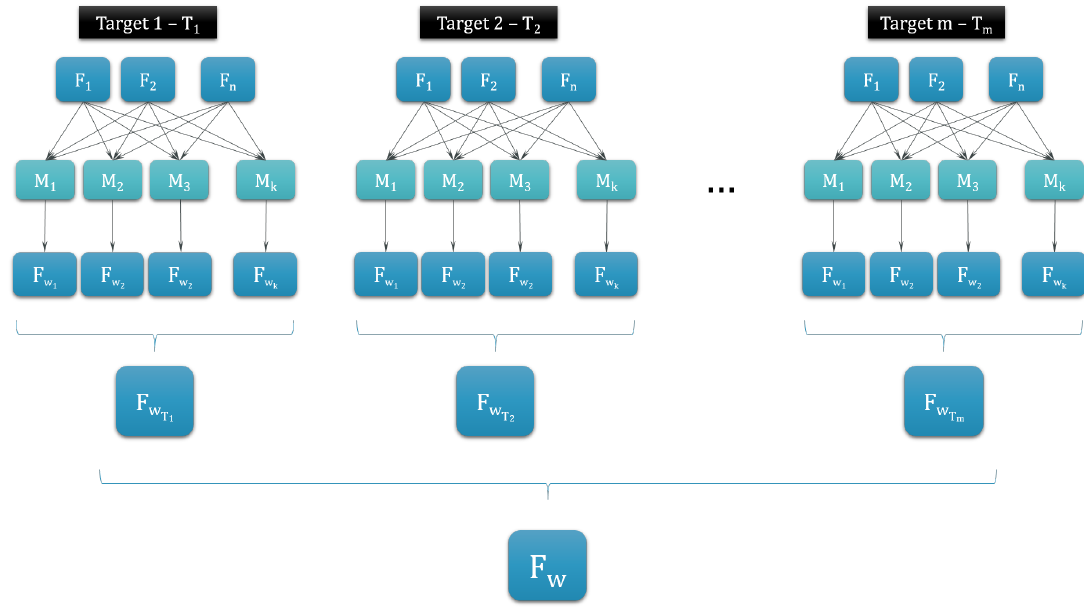
Figure 2. The pipeline of ranking the feature sets by using the PROMETHEE method. F represents a subset of questions, and M represents one of the chosen statistical or machine-learning methods. F w the subset on which method M i performs the best, and F w M perform the best. F w is the subset of features on which methods perform the best for all